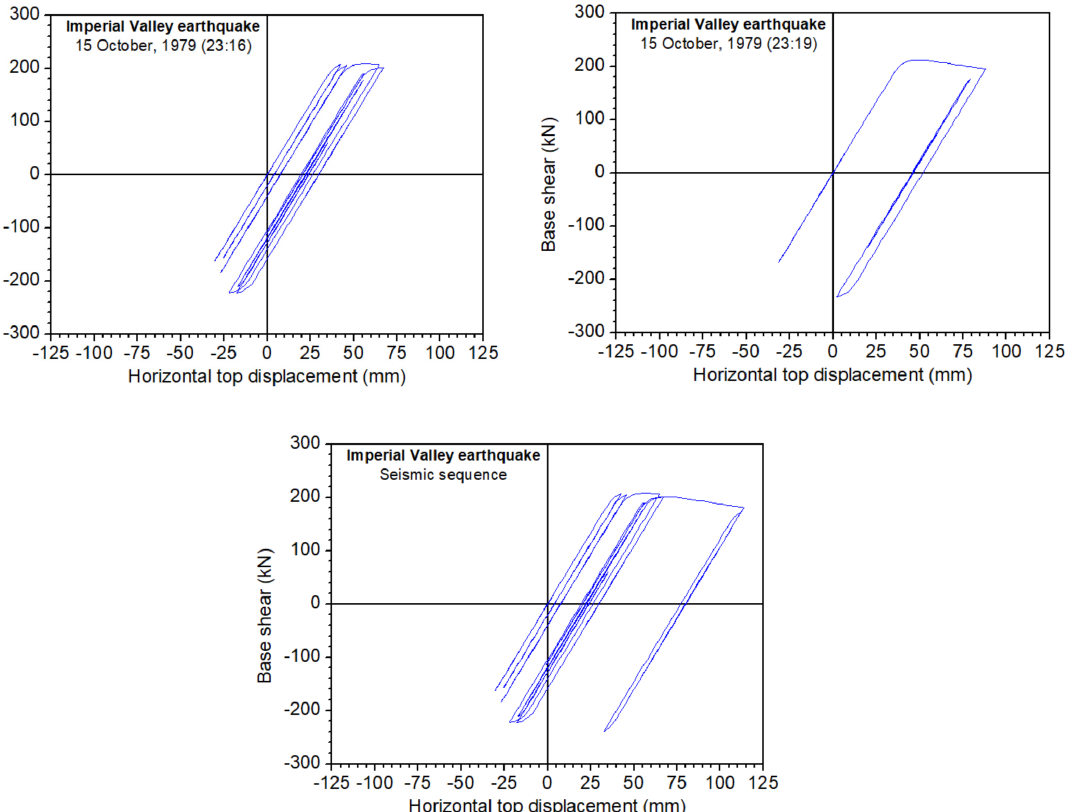
Figure 13. Fixed-base platform under the Imperial Valley earthquake (15 October 1979, 23:16~23:19): single seismic events vs. seismic sequence.